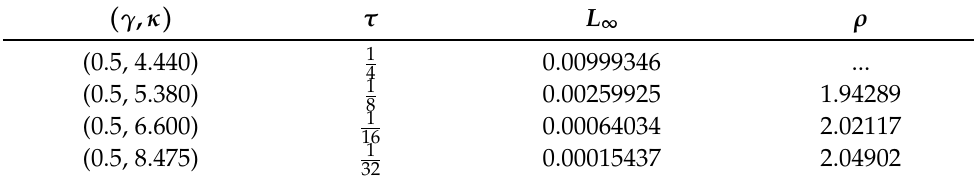
Table 8. The L ∞ error norm and ρ of Example 2 for ˜ M = 160.